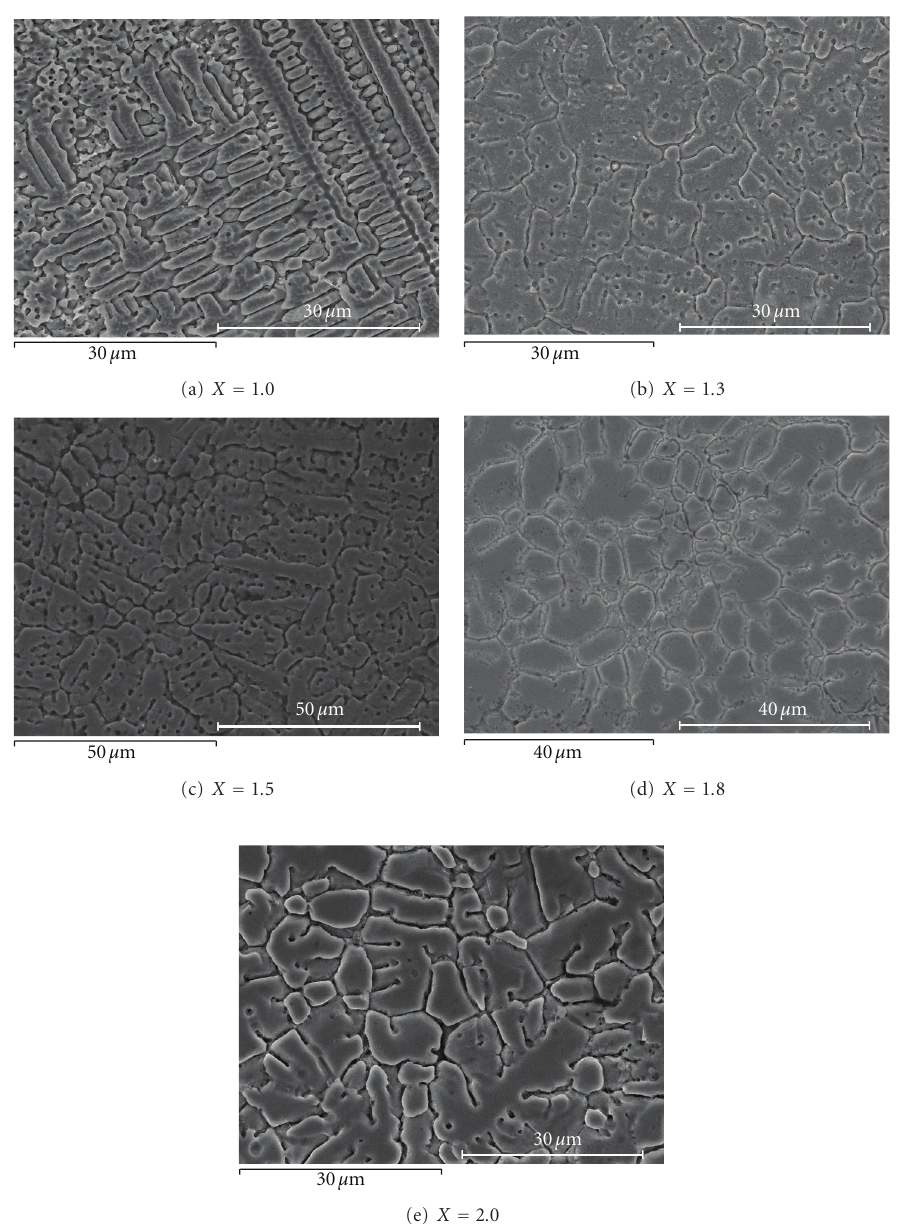
Figure 2: Typical microstructure of Al X FeCoNiCuCr clad layer, etching in aqua regia for a few minutes: (a) X = 1 . 0, (b) X = 1 . 3, (c) X = 1 . 5, (d) X = 1 . 8, and (e) X = 2 .